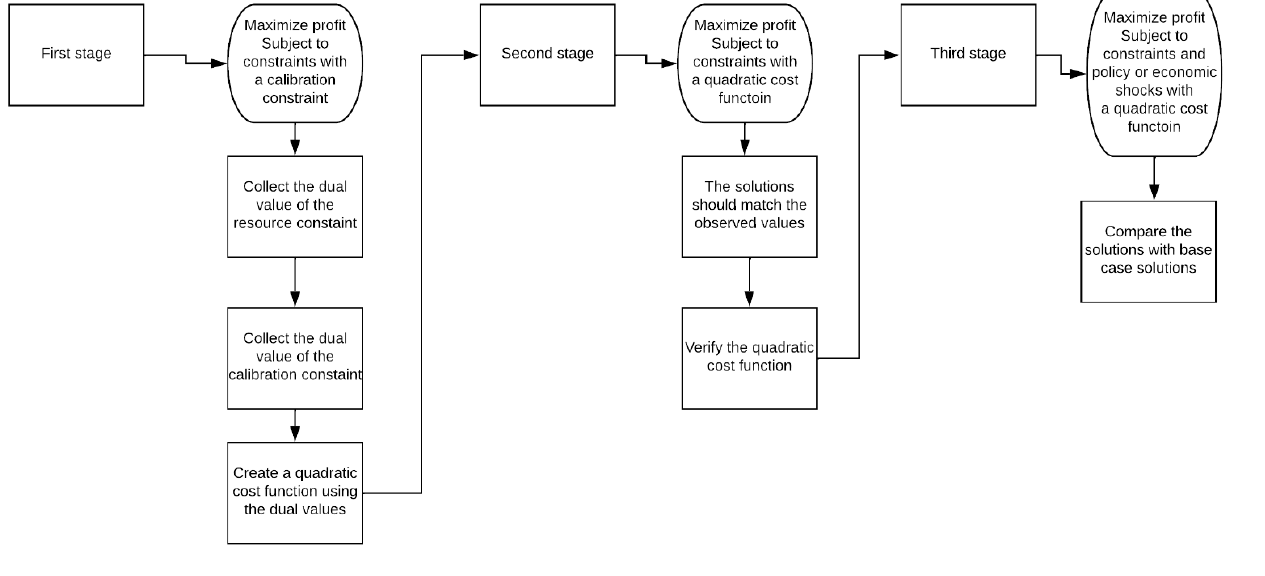
Figure 1. The flow chart of the PMP three stages.